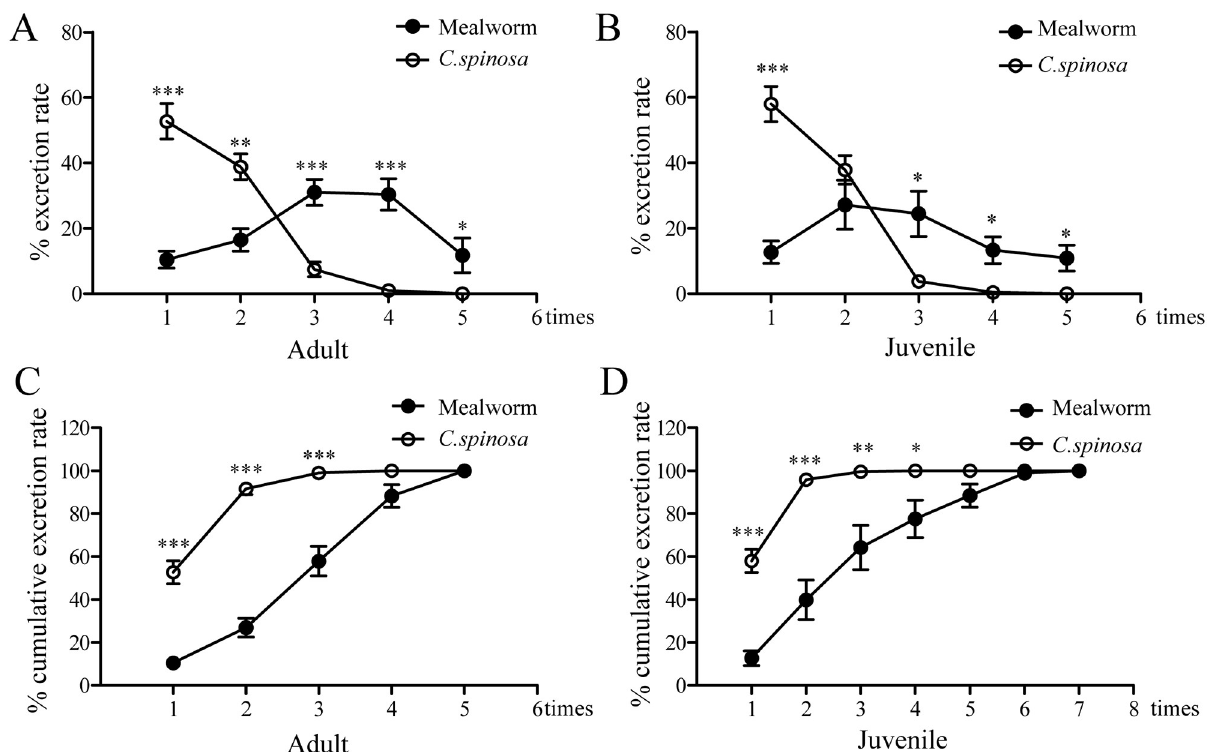
Fig 3. Effects of age and food type on excretion rate and cumulative excretion rate in adult and juvenile lizards. (A, B) The excretion rates of mealworms and C . spinosa in adult and juvenile lizards. (C, D) The cumulative excretion rates of mealworms and C . spinosa in adult and juvenile lizards. The data were analyzed by a two-tailed paired t test. � P < 0.05; �� P < 0.01; ��� P < 0.001.